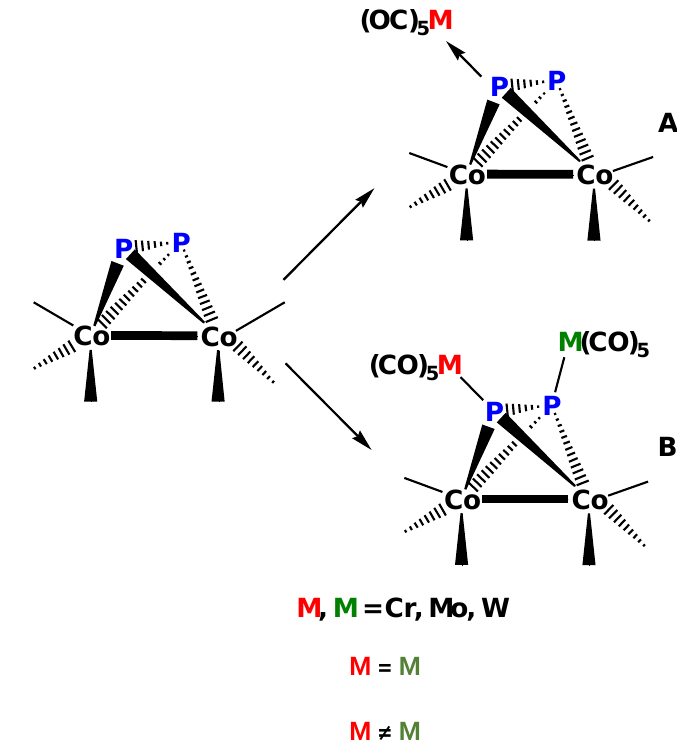
Figure 16. Schematic views of the structures ( A ) of complexes 26 and ( B ) of complexes 27 [73].